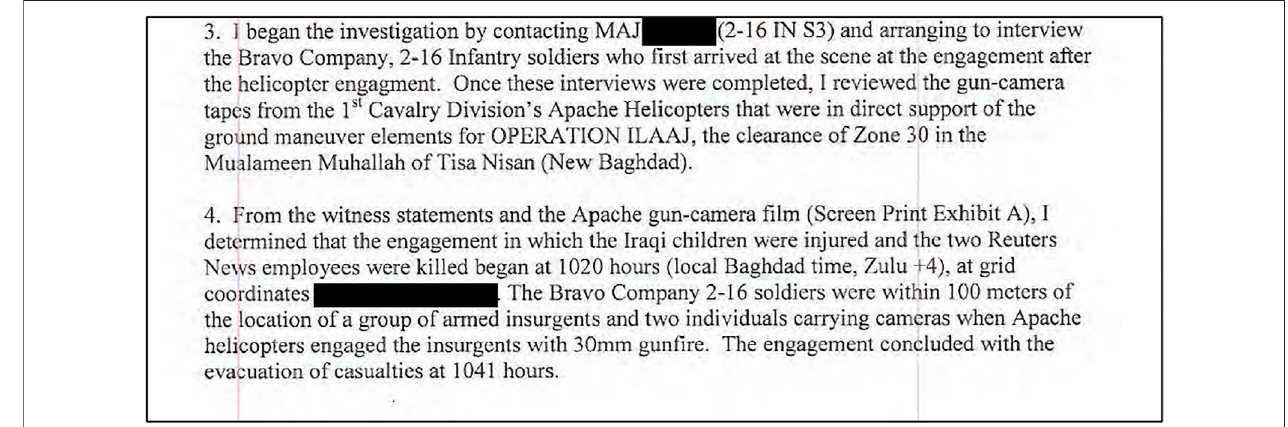
FIGURE 3 | Redacted extract from the US military AR 15-16 investigation (Iraq, July 12, 2007).